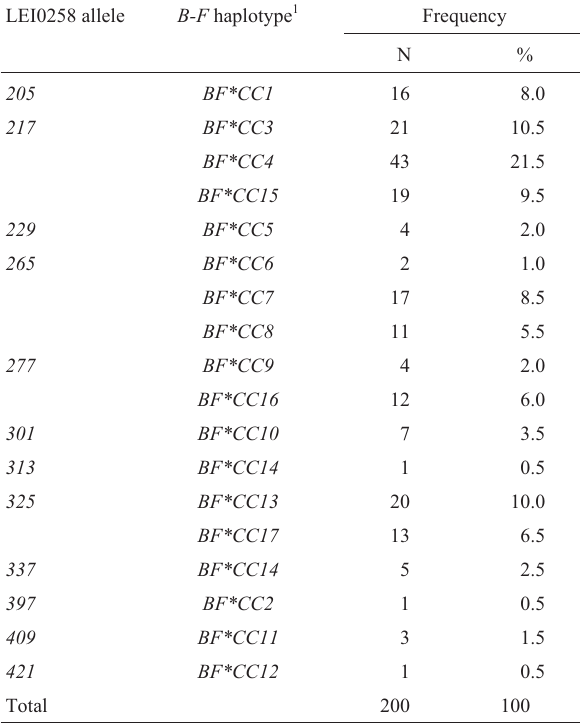
Table 2 - Association between the LEI0258 alleles and B-F haplotypes in blue-egg Caipira